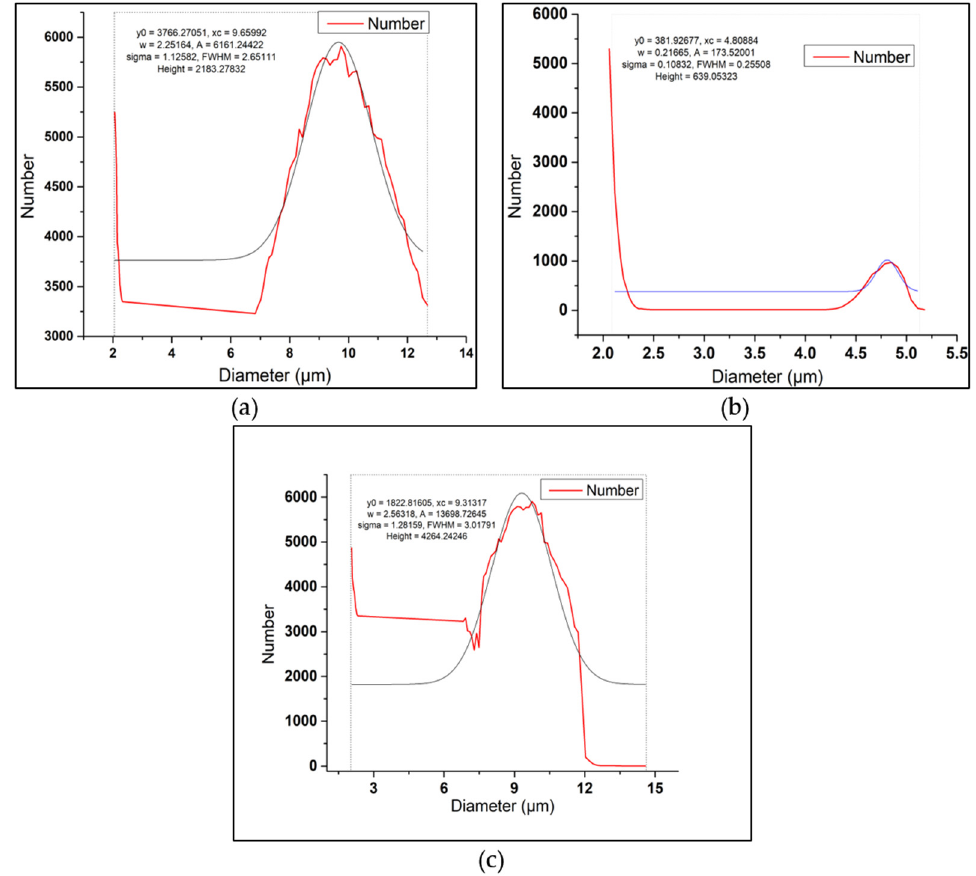
Figure 4. Particle size analysis curves of ( a ) Silicon Carbide powder ( b ) Rice Husk Ash, and ( c ) Carbonized Eggshell Powder. (Red line represents actual curve while the grey line represents Gaussian Curve Fit)